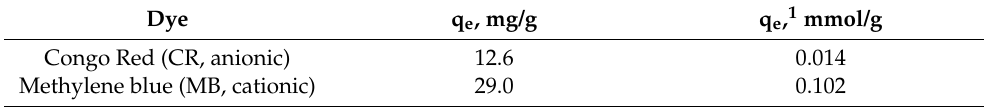
Table 1. Adsorption capacities of DNA–CS hydrogel (CS90) for CR and MB dyes. Dye q e , mg/g q e , 1 mmol/g Congo Red (CR, anionic) 12.6 0.014 Methylene blue (MB, cationic) 29.0 0.102